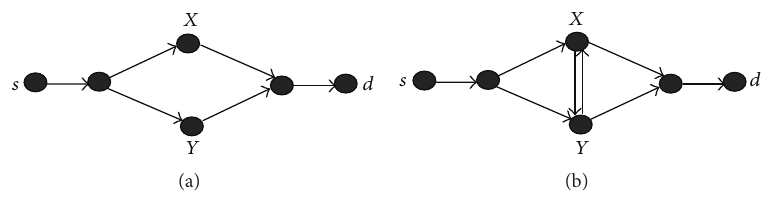
Figure 1: (a) Series-parallel network. (b) Arbitrary network.